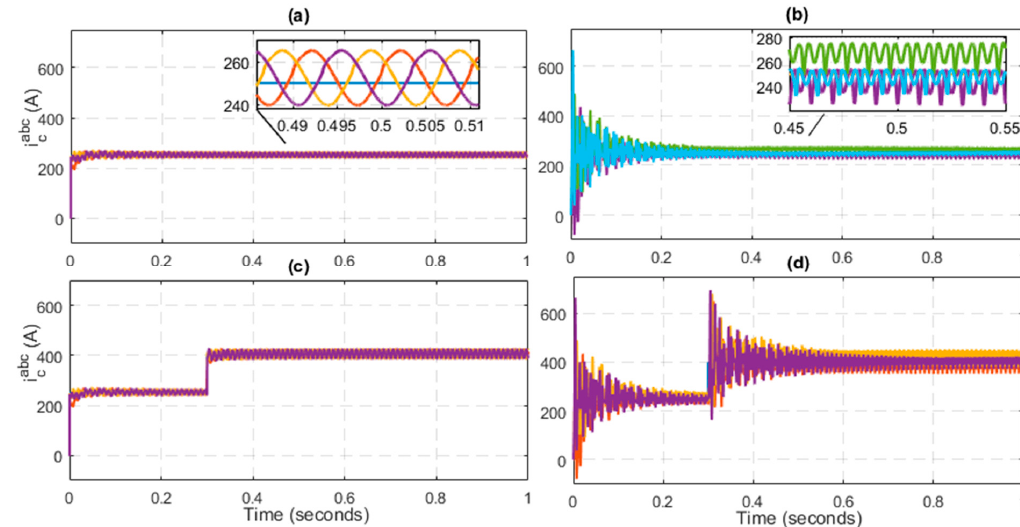
Figure 5. Circulating current ( a ) Proposed controller with constant reference; ( b ) Proportional resonant (PR) controller with constant reference; ( c ) Proposed controller with stepped reference; ( d ) PR controller with stepped reference.